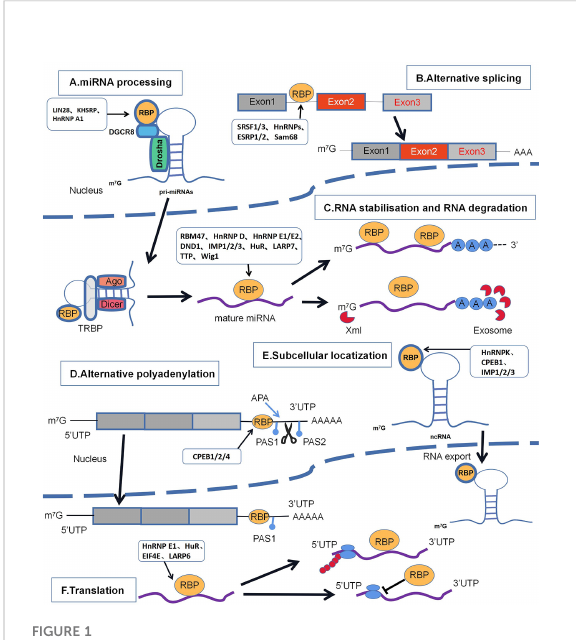
FIGURE 1 Major regulatory mechanisms of RBPs in breast cancer. including (A) miRNA processing; (B) selective splicing; (C) RNA stabilization and RNA degradation; (D) selective polyadenylation; (E) subcellular localization; (F) translation. The schematic diagram lists the RBPs involved in the regulatory mechanisms of breast cancer that appear in the